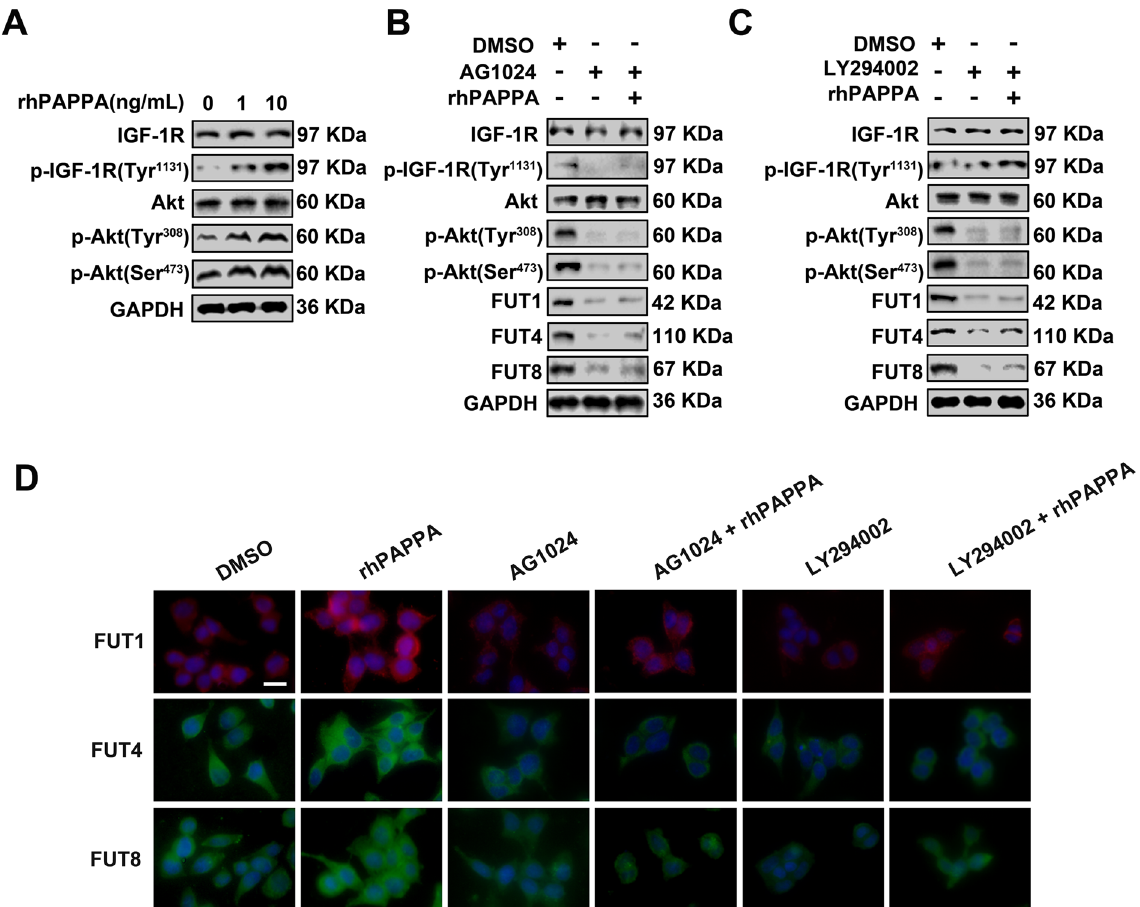
Figure 5. rhPAPPA stimulates the expression of FUT1/4/8 through the IGF-1R/PI3K/Akt signaling pathway. Ishikawa cells were differently treated with rhPAPPA, AG1024, LY294002. ( A ) Westerrn blotting showed the expression of IGF-1R, p-IGF-1R (Tyr 1131 ), Akt, p-Akt (Tyr 308 ) and p-Akt (Ser 473 ). ( B,C ) Western blotting analyzed the molecules of the IGF-1R/PI3K/Akt signaling pathway and FUT1/4/8 expression. (D ) Immunofluorescent staining of FUT1/4/8. DAPI (blue) was used for nuclear staining. GAPDH was used as an internal control. The bar represents 50 μ m. The data were presented as the means ± SEM of three independent